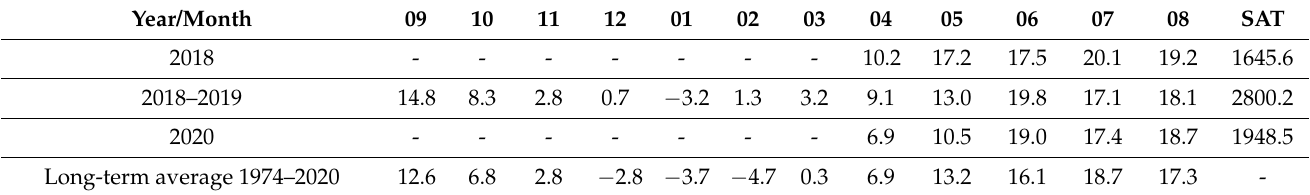
Table 1. Average temperature ( ◦ C) and the sum of the active temperatures (SAT) during the